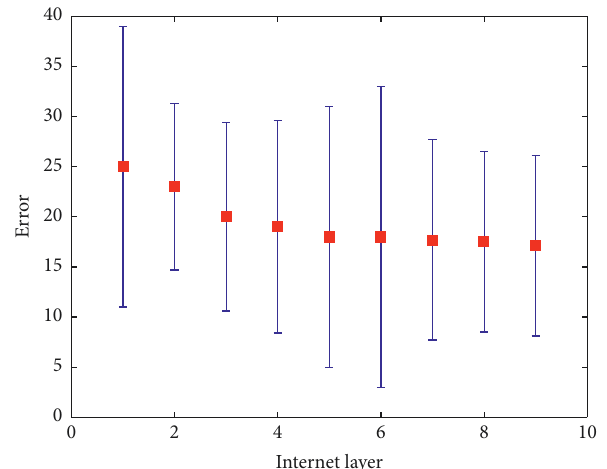
Figure 8: Synergy error analysis of different network layers.